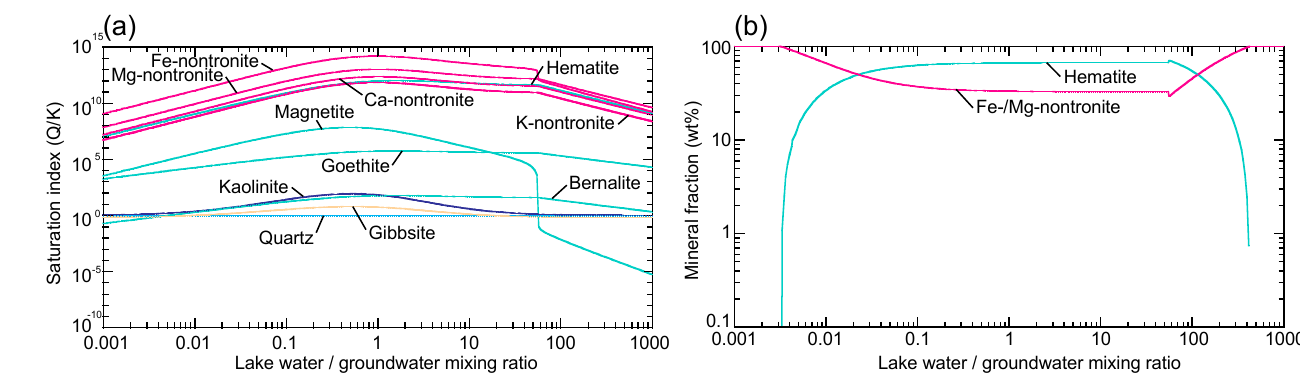
Figure 6. ( a ) mineral saturation indices and ( b ) mineral assemblages when lake water and groundwater (composition shown in Table 3) mixed under various lake water-to-groundwater mixing ratio at 5 °C .